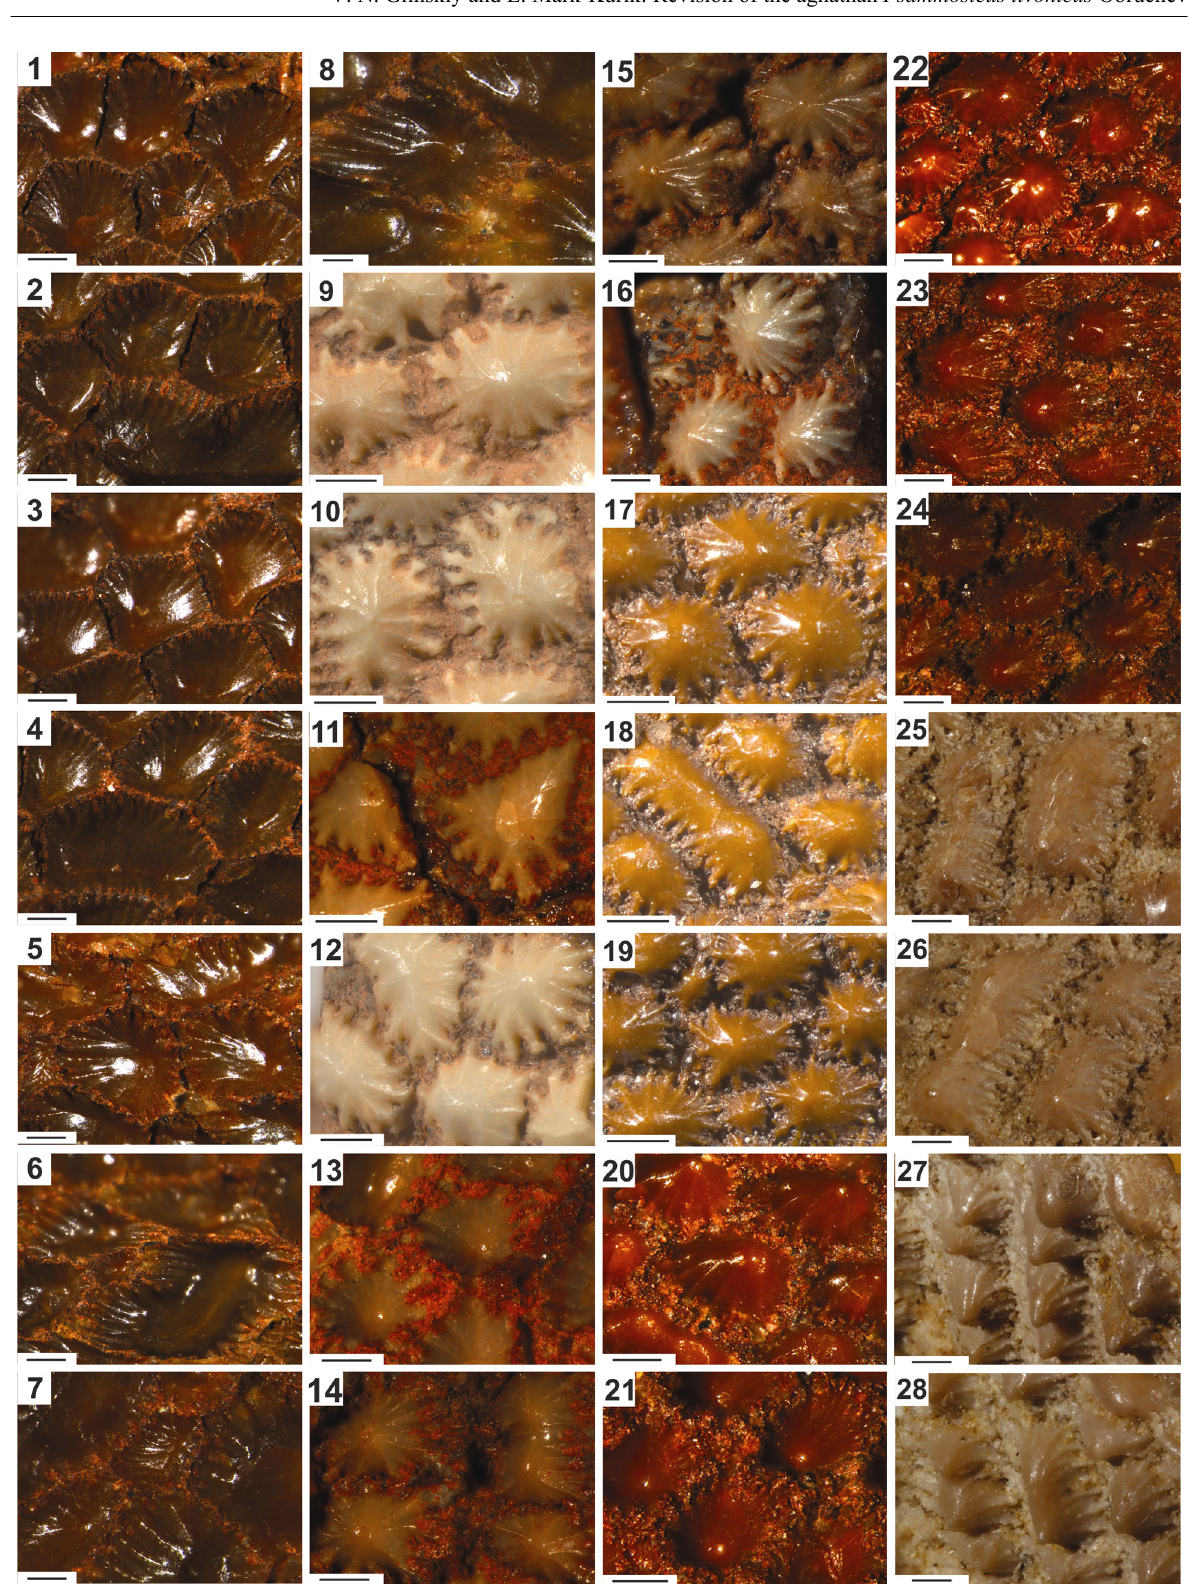
Fig. 6. Psammosteus livonicus Obruchev, topographic variability of the ornament. Details of ornamentation are shown in Fig. 4. 1 – 8 , PIN 220/527, left branchial plate; 9 – 16 , PIN 1737/7, holotype, right branchial plate; 17 – 24 , PIN 1737/74, right branchial plate; 25 – 28 , GIT 116-275, left branchial plate. Scale bars: 1–6, 9–28 = 0.5 mm; 7, 8 = 0.2